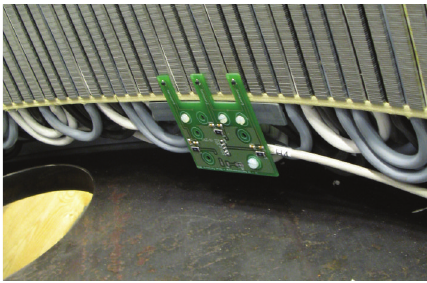
Figure 6: Hall sensors on a PCB screwed to a plastic mount attached to the stator.